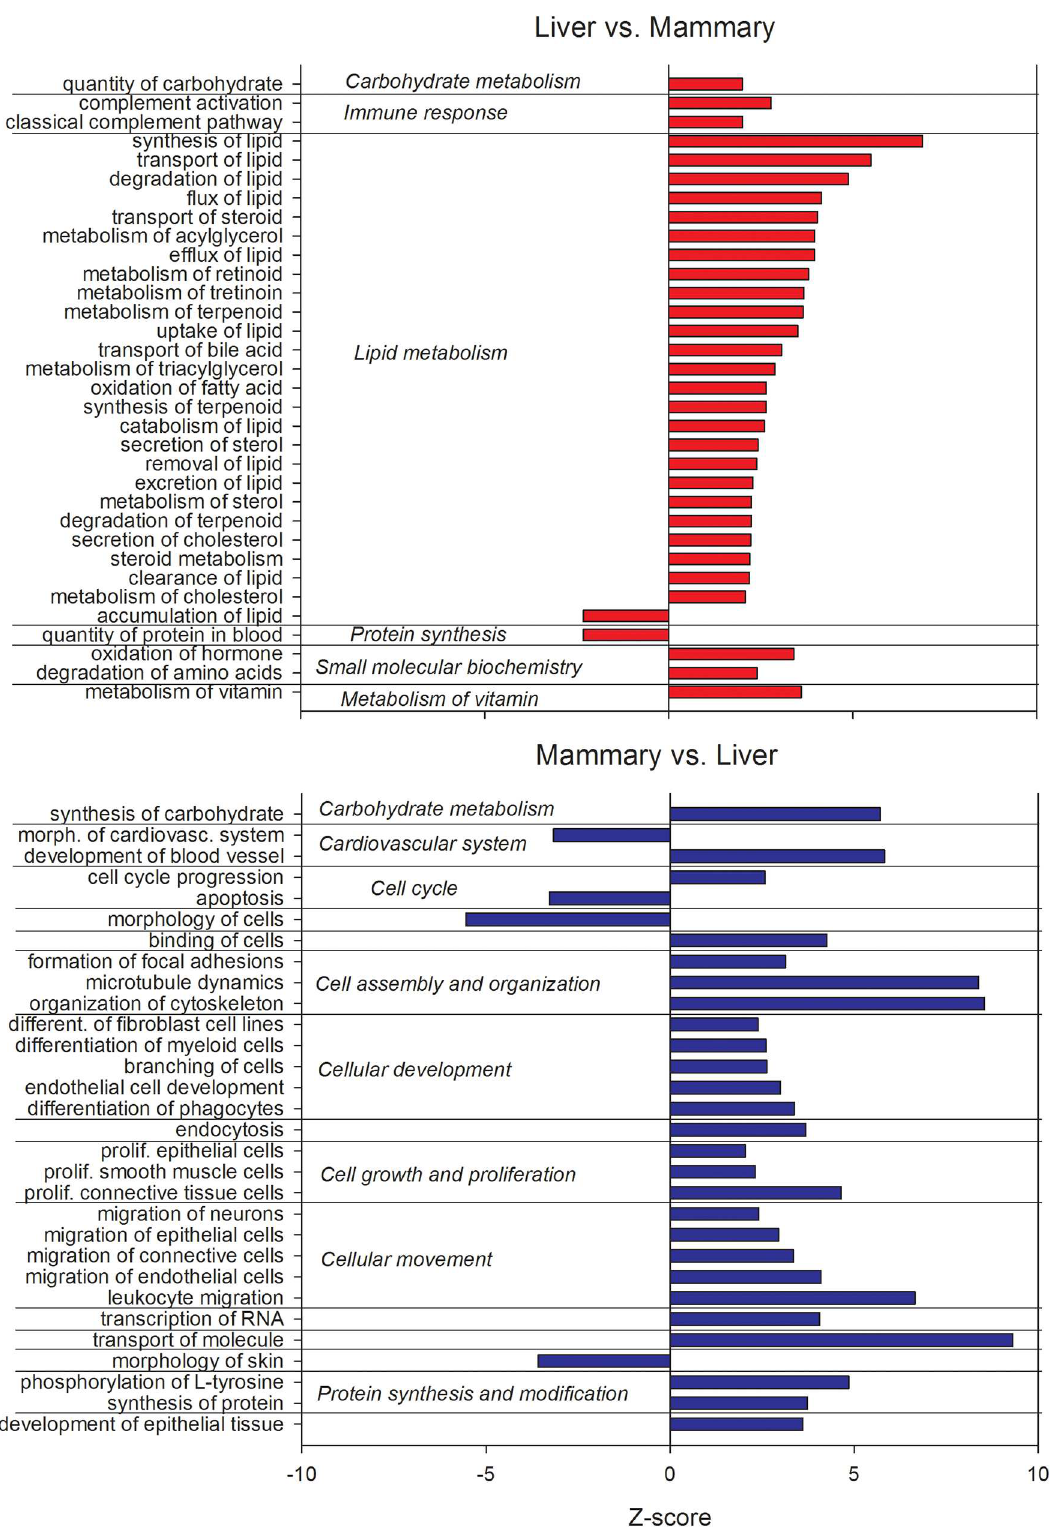
Fig 4. Function with a Z-score (cid:21) 2 of DEG more expressedin liver vs . mammarytissue (upper panel) and DEG more expressedin mammarytissue vs . liver (lower panel). The Z-score is an estimate of the activationor inhibitionof